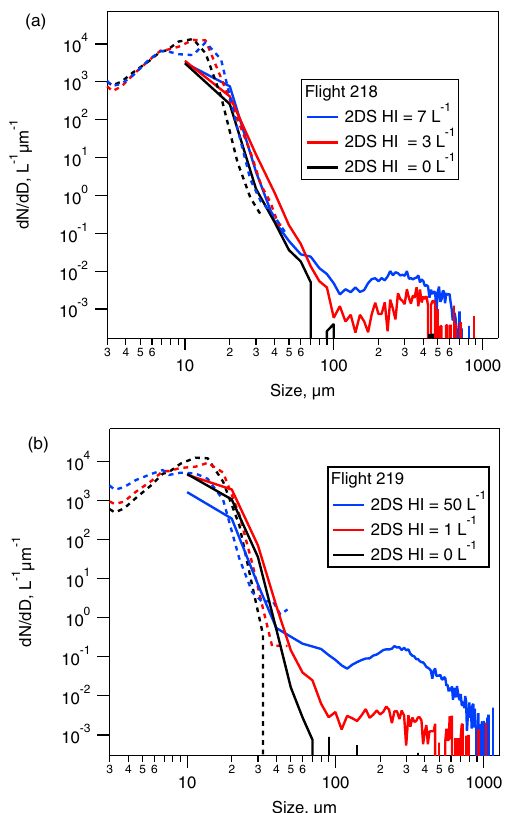
Figure 6. (a) Comparison between the particle size distributions for three regions sampled in the constant altitude run at − 5 ◦ C during Flight 218; these are where the concentration of highly irregular particles (2DS HI) was 7L − 1 (16:04GMT), 3L − 1 (15:58GMT) and 0L − 1 (15:52GMT). Time series of the microphysical measure- ments during this run are shown in Fig. 7. Panel (b) shows a similar plot for a run at − 6 ◦ C during Flight 219 when the 2DS highly ir- regular concentration was 50, 1 and 0L − 1 . Dashed lines show mea- surements from the CAS and solid lines are from the